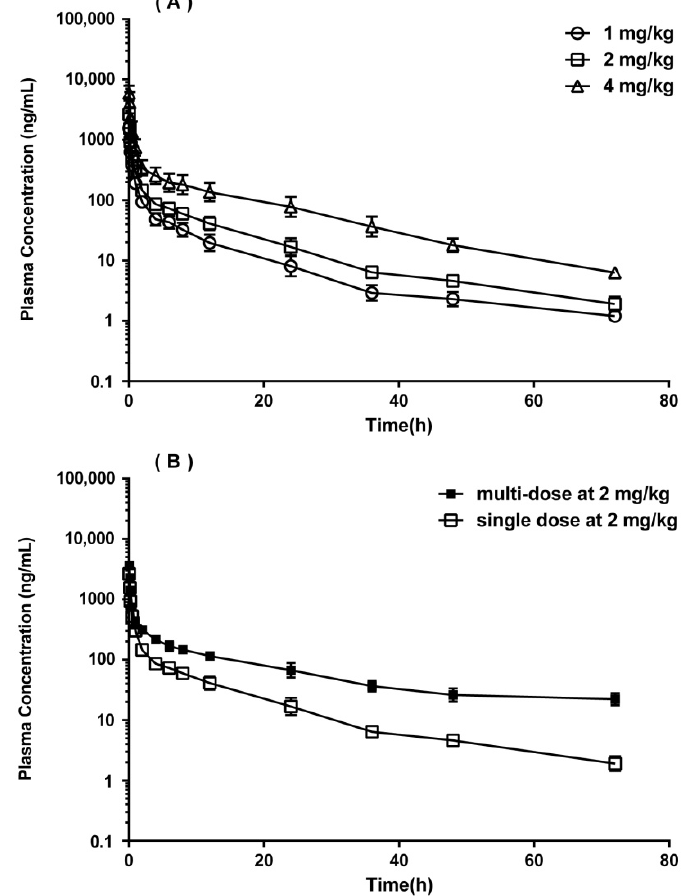
Figure 3. Mean plasma concentration-time profiles (semi-log graph) of GC20 in rats: ( A ) after intravenous administration of GC20 at three single doses (1, 2, 4 mg / kg); ( B ) after consecutive administration of GC20 for 7 days at 2 mg / kg compared to single administration of GC20 at 2 mg / kg. The data are expressed as mean ± SD from all rats in each dosing group (n = 6). Table 5. Pharmacokinetic parameters after intravenous administration (i.v.) of GC20 at a single dose (1, 2, 4 mg / kg) or after receiving a dose of 2 mg / kg on seven consecutive days. (mean ± SD from all rats in each dosing group, n = 6).